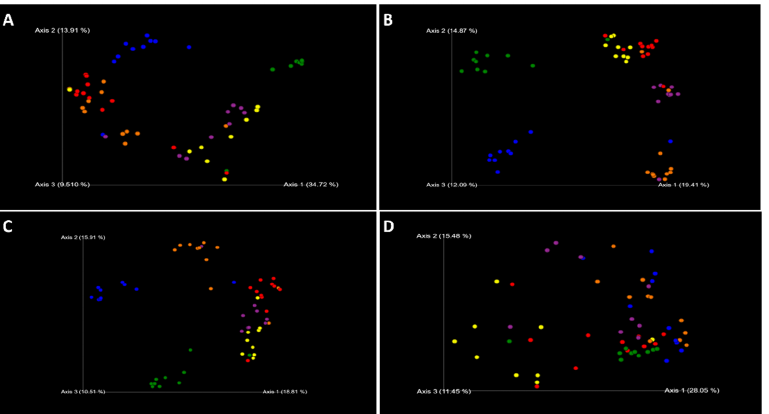
Figure 6. Principal coordinate analysis (PCoA) of the bacterial community compositions in different systems using Bray–Curtis dissimilarity ( A ), Jaccard similarity index ( B ), unweighted UniFrac ( C ), and weighted UniFrac ( D ) NOTE: red: 22 °c copper, blue: 32 °C copper, orange: 22 °C PEX, green: 32 °C PEX, purple: 22 °C steel, yellow: 32 °C steel. Table 2. Pairwise PERMANOVA comparison of microbial composition (beta diversity) based on pipe material and temperature condition. Group 1